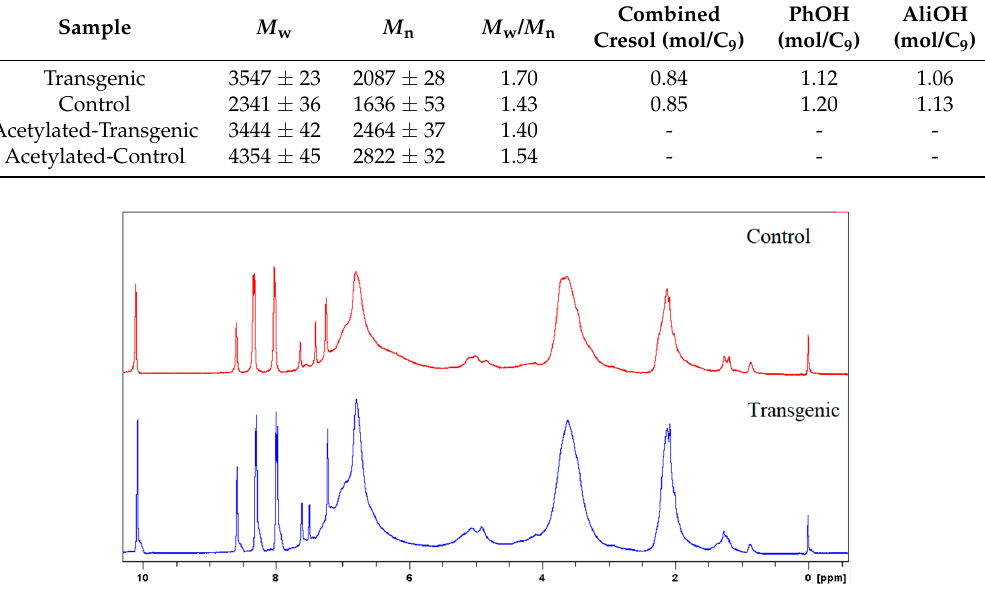
Figure 3. 1 H NMR spectra of LCs.